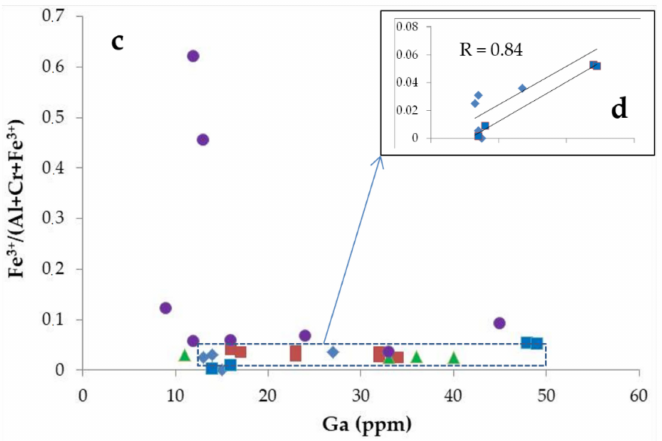
Figure 2. Plots of the Cr / (Cr + AI) atomic ratio versus Ga content ( a ); the Cr / (Cr + AI) ratio versus V content ( b ) and the Fe 3 + / (Al + Cr + Fe 3 + ) ratio versus Ga content ( c ), including a detailed plot for the Vourinos and Kempirsai samples ( d ). Data from the Table